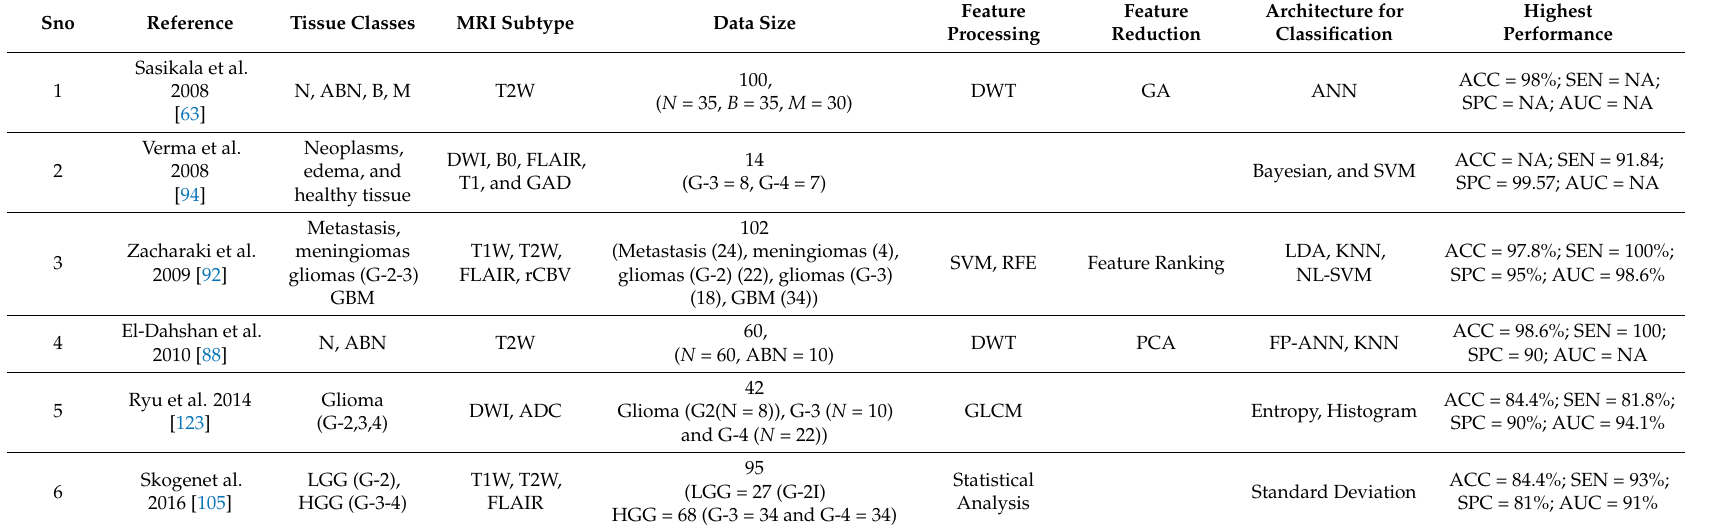
Table 5. Overview of Brain Tumor Classification